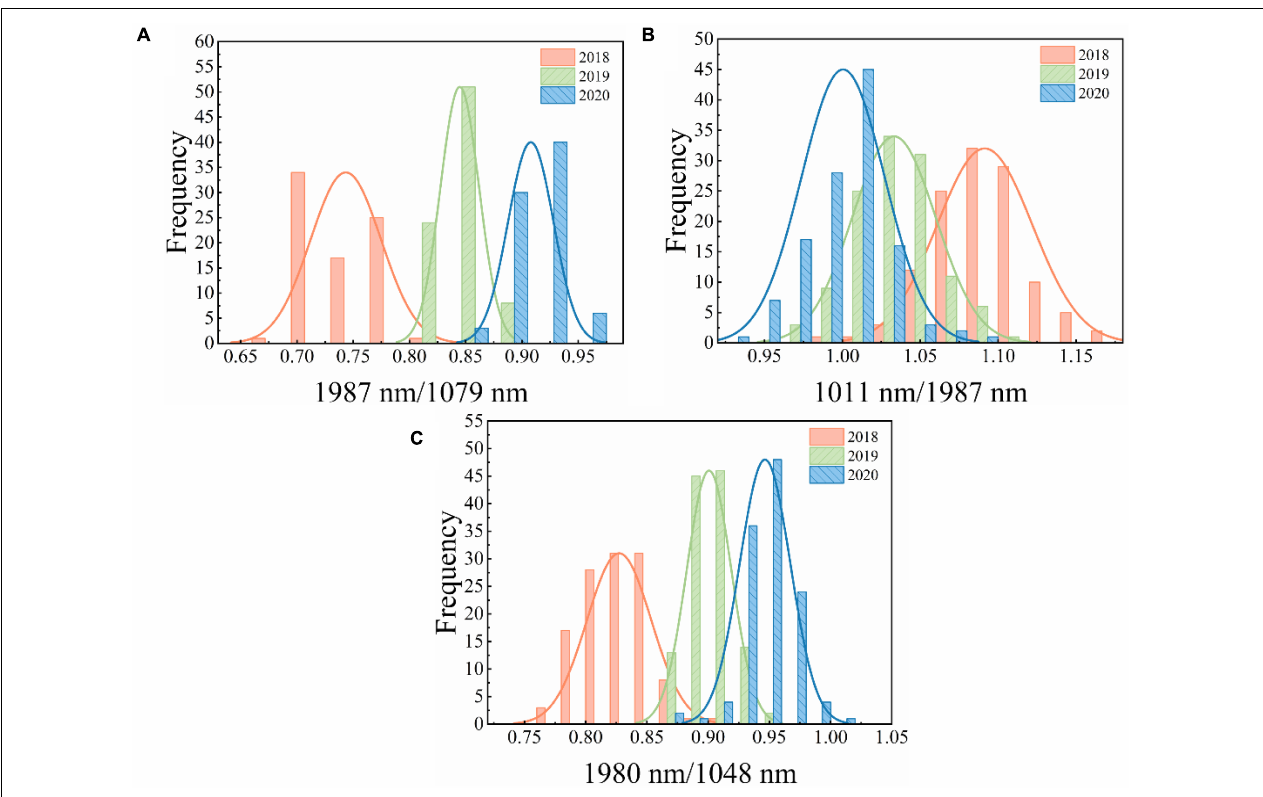
FIGURE 4 | The distribution of two-band ratio for different samples. (A) Embryo side, (B) endosperm side, and (C) both sides. TABLE 4 | The classification results using threshold values based on the two-band ratio values. Spectral